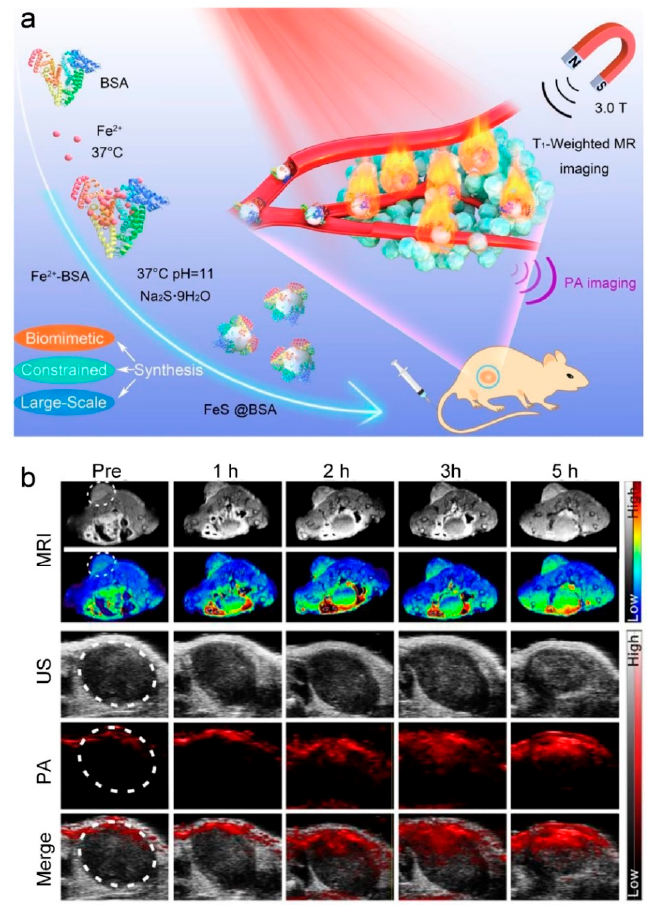
Figure 10. ( a ) Schematic representation of bovine serum albumin (BSA)-constrained biomimetic synthesis of 3 nm FeS@BSA for in vivo T 1 -weighted MR/phototheranostics dual-mode imaging-guided photothermal therapy (PTT) of tumors. ( b ) In vivo T 1 -weighted MR, US, PA, and merged (US and PA) images of tumor after intravenous injection of at a dose of 20 mg FeS@BSA kg − 1 (adapted from Zhang et al. 2020 [104], Copyright 2020 Elsevier Ltd. and reproduced with permission).